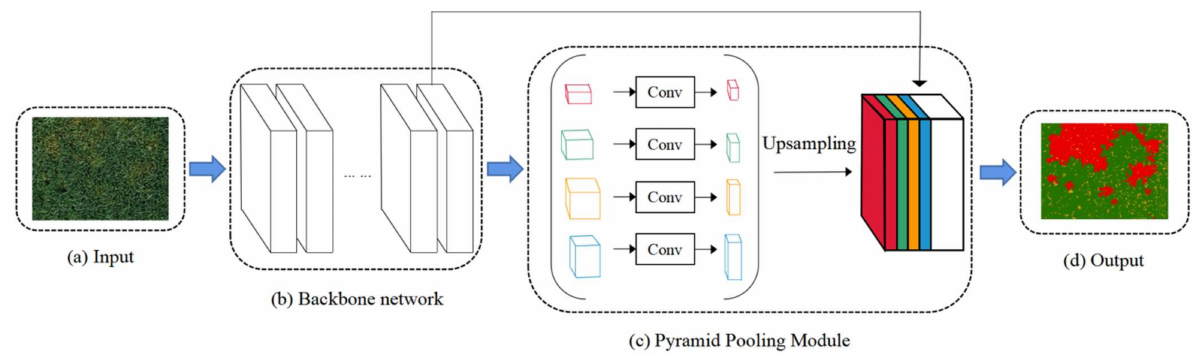
Figure 4. The flow of identification of yellow rust of wheat based on PSPNet: ( a ) a drone image of a wheat field; ( b ) the backbone network of the PSPNet model; ( c ) the pyramid pooling module; ( d ) the predicted output results of the original image, where the red area indicates wheat with yellow rust, the green area indicates healthy wheat, and the yellow area indicates bare